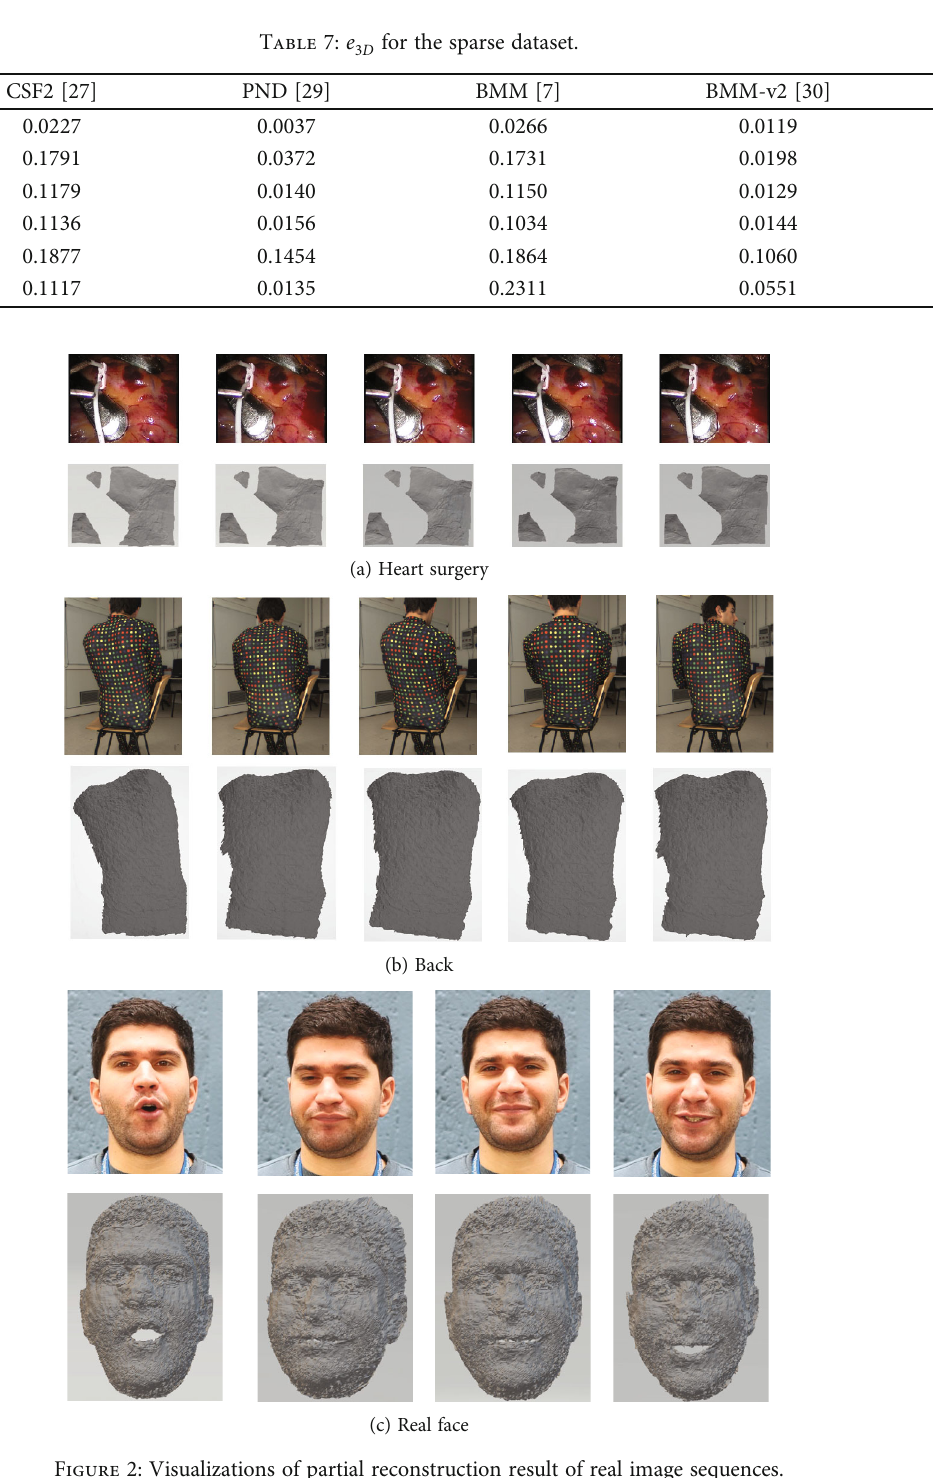
Figure 2: Visualizations of partial reconstruction result of real image